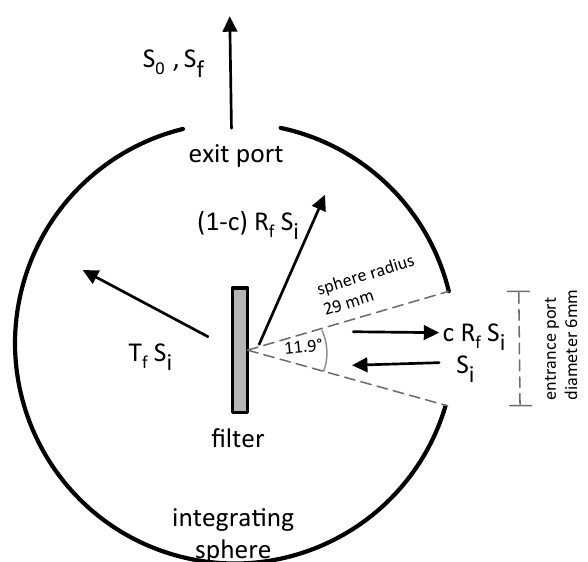
Figure 3. Setup of measurements inside the integrating sphere. The filter is placed in the center of the sphere and illuminated through the entrance port. Reflected and transmitted light is scattered many times on the walls of the sphere before measured at the exit port. The radiant fluxes are indicated by arrows and explained in the